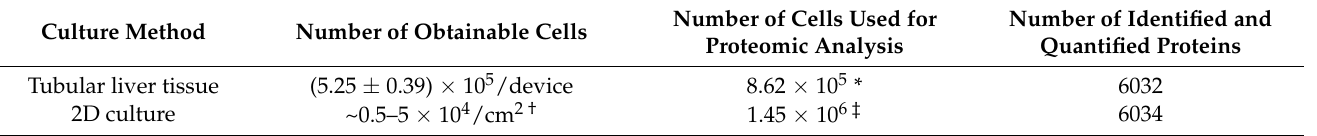
Table 1. Quantitative characteristics of the experimental systems and proteomic analysis output. Culture